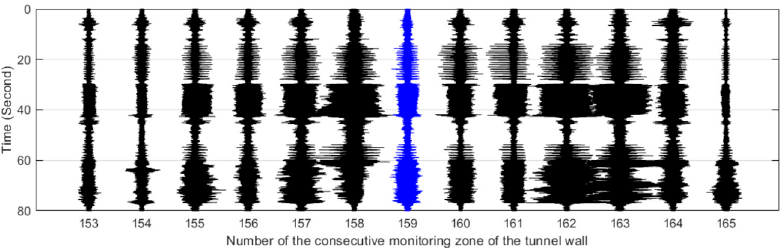
Figure 13. Distributed vibration responses of 13 consecutive monitoring zones under the perturbation of position P3.